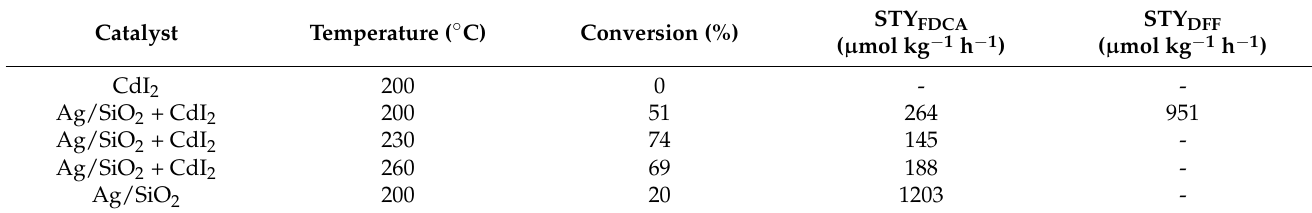
Table 3. Effect of the temperature on FDCA synthesis from K 2 F using Ag/SiO 2 and CdI 2 catalysts. Conditions: 17 mg of CdI 2 ; 35 mg of K 2 F; 50 mg of Ag/SiO 2 ; F N2 = 45 mL/min; 20 rpm; T = 200 – 260 °C; t = 20 h. Adapted with permission from Ref. [72].